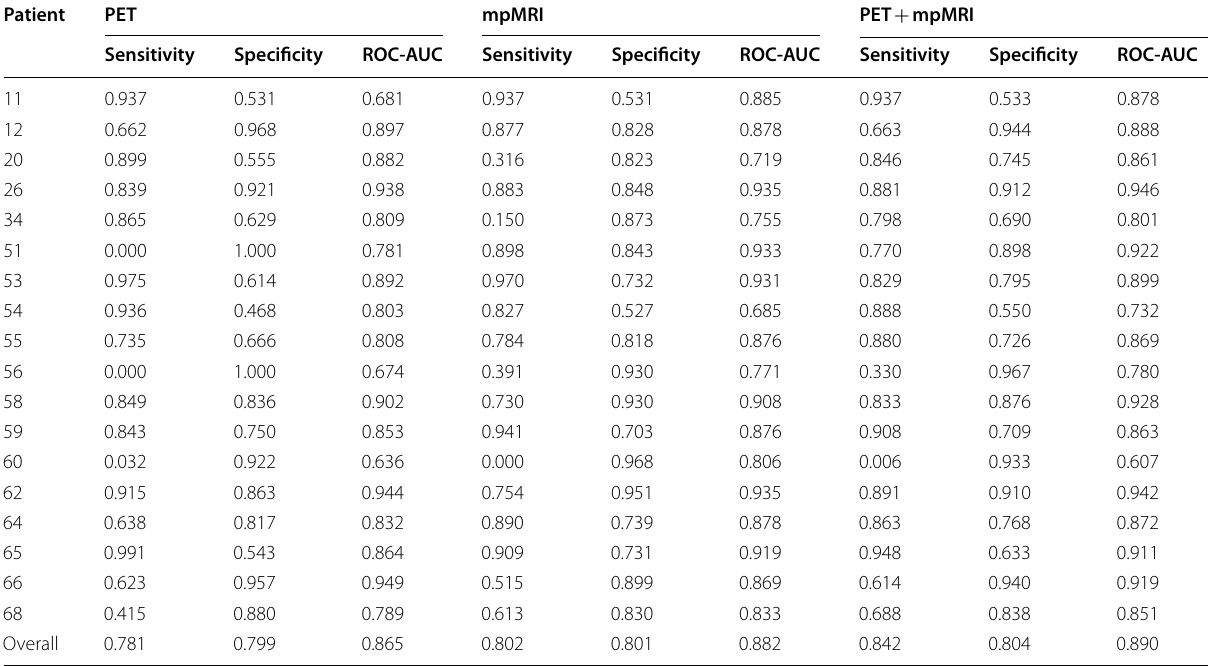
Table 3 Patient-wise leave-one-out performance of each RFC detection model and the overall performance Patient